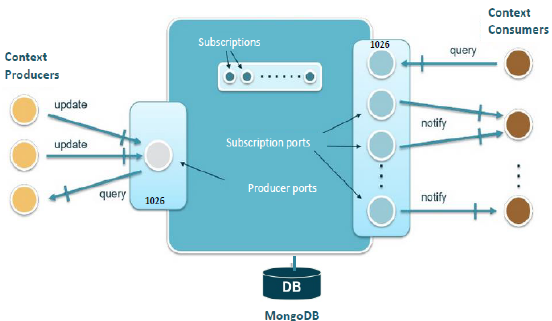
Figure 1 Logical architecture of the Context